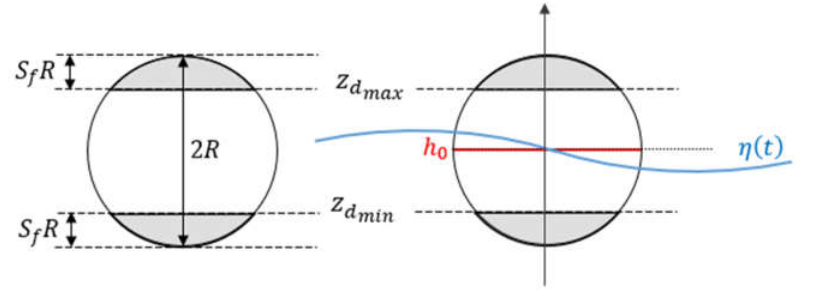
Figure 4. Spherical buoy limits of displacement.